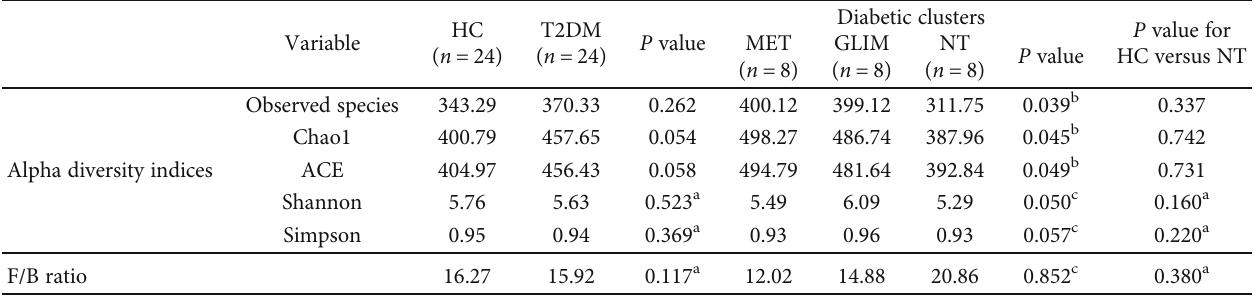
Table 2: E ff ect of T2DM and antidiabetic agents on alpha diversity indices and Firmicutes/Bacteroidetes ratio.